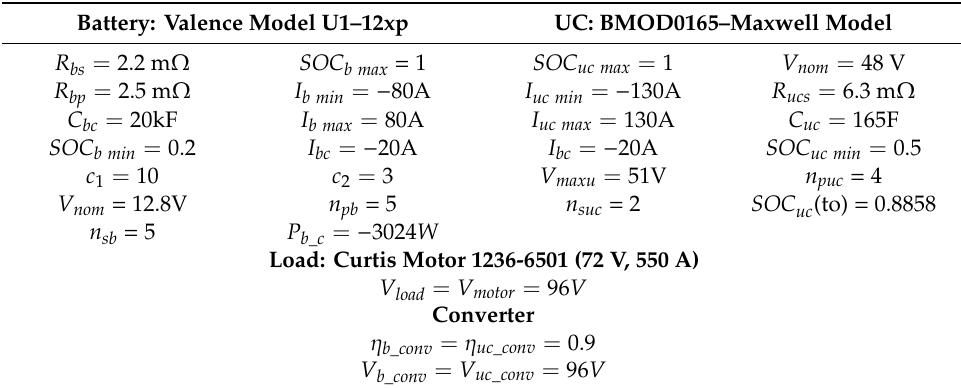
Table 2. Powertrain parameters.